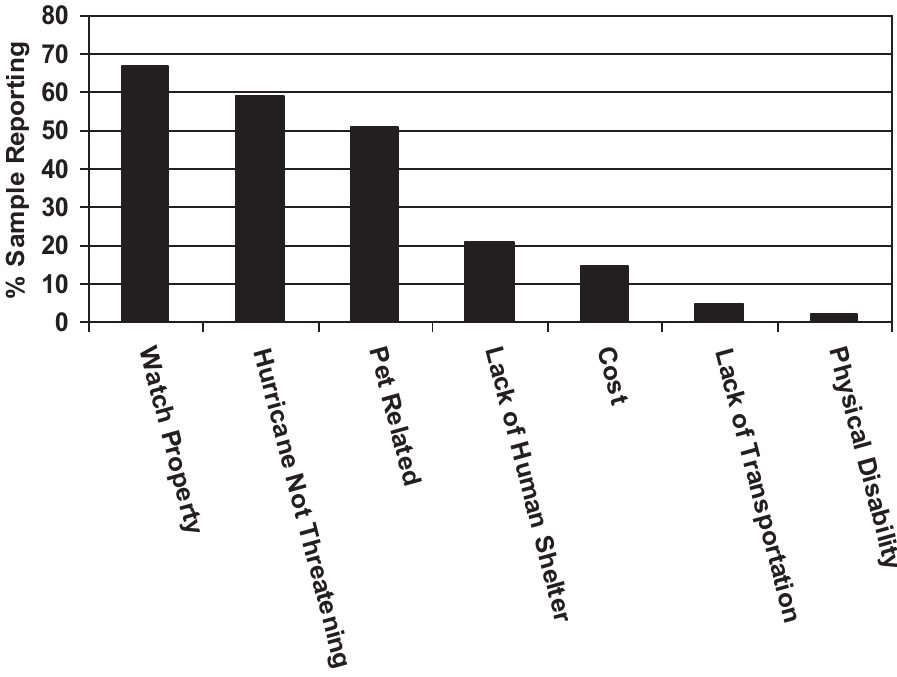
Figure 2. Reasons for Evacuation Failure by Pet